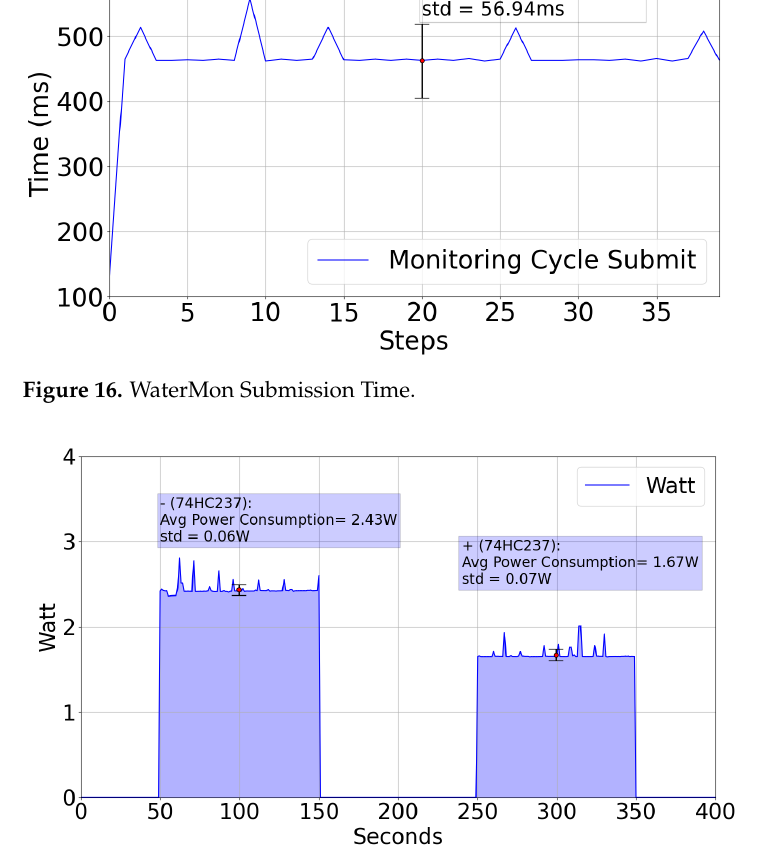
Figure 17. Power Consumption with and without IC